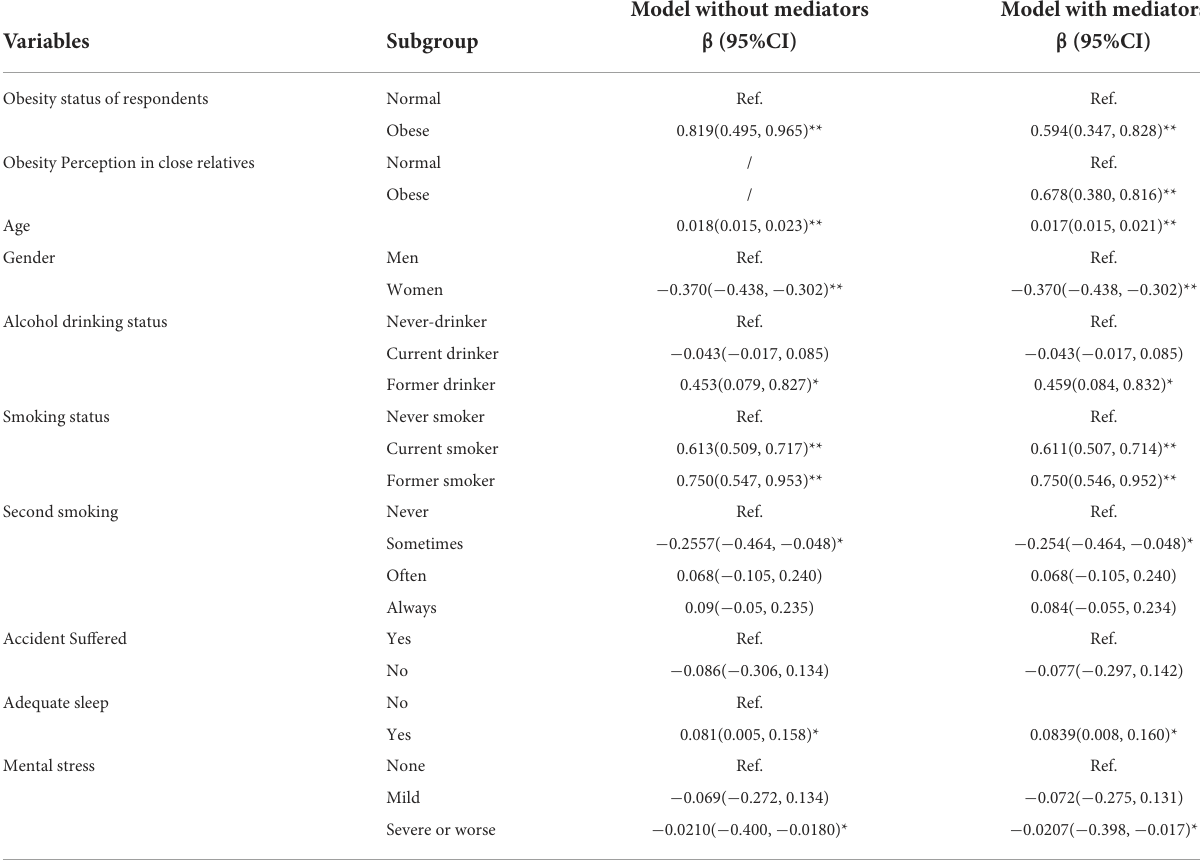
TABLE 3 The mediating effect of obesity perception in close relatives on the association between obesity and weight control behavior scores among adults in Chongqing, China.